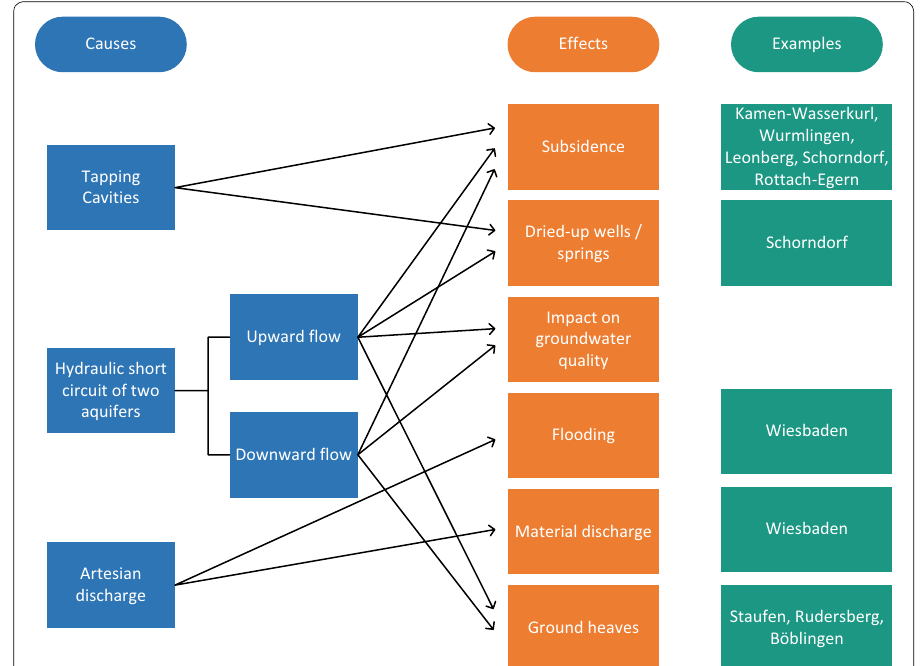
Fig. 5 Cause-and-effect diagram of vertical GSHP in Germany [modified after Grimm et al.